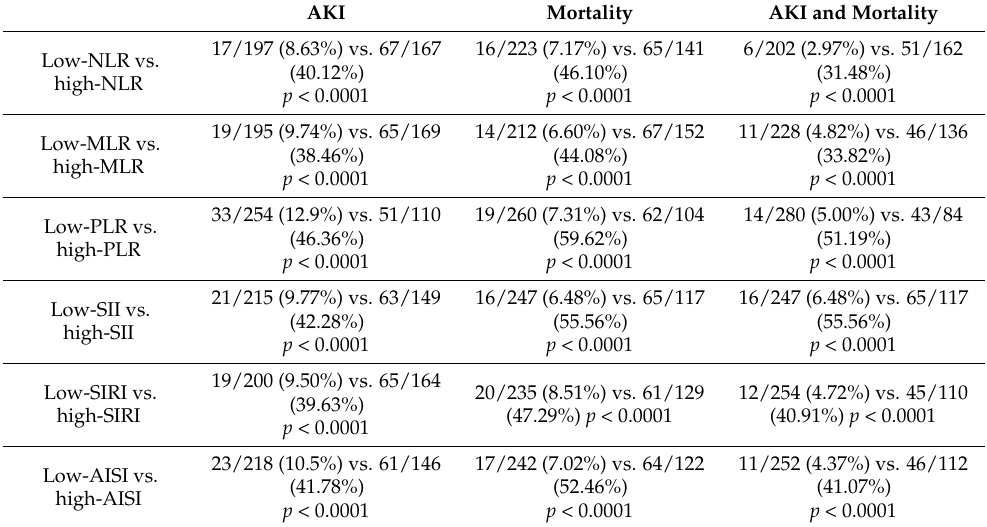
Table 3. Univariate analysis of all inflammatory biomarkers and adverse event occurrences in all patients over the study period.